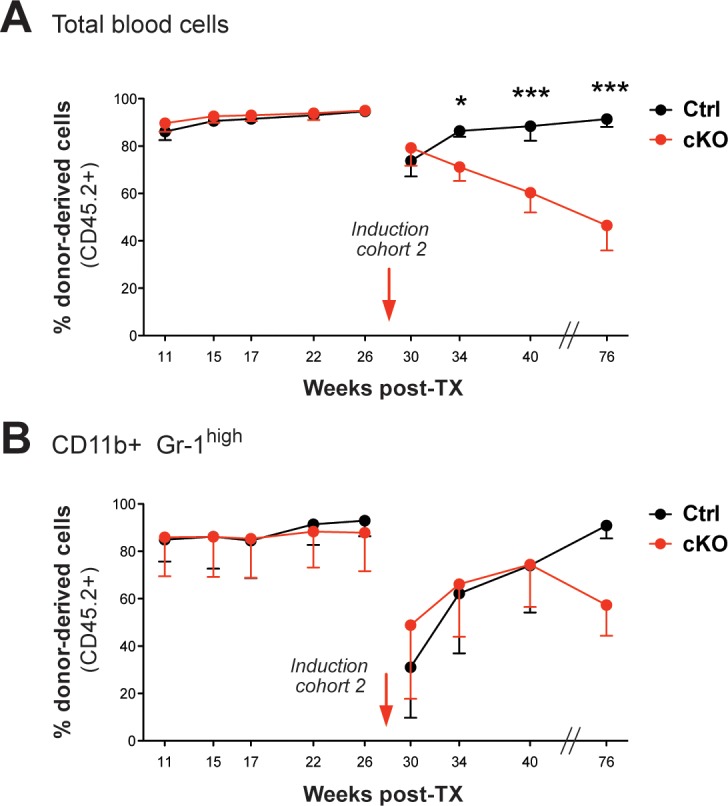
FACS analysis of the CD45.1/2 chimerism in peripheral blood (cohort 2).(A) Immediately after tamoxifen induction, the initially high percentages of CD45.2+ donor-derived cells in blood (91–96%) continuously dropped in cKO transplanted mice (p*<0.05, p***<0.001). (B) Despite an obvious decline of CD45.2+ granulocytes (CD11b+ Gr-1high) in all transplant recipients after induction, the levels recovered over time. The graphs depict the mean ± SD.